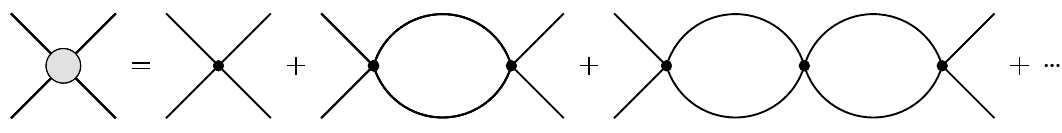
Figure 11 . Feynman diagrams for wino-wino scattering in the zero-range model without electro- magnetism. Bubble diagrams must be summed to all orders. The solid lines are winos, which can be either neutral or